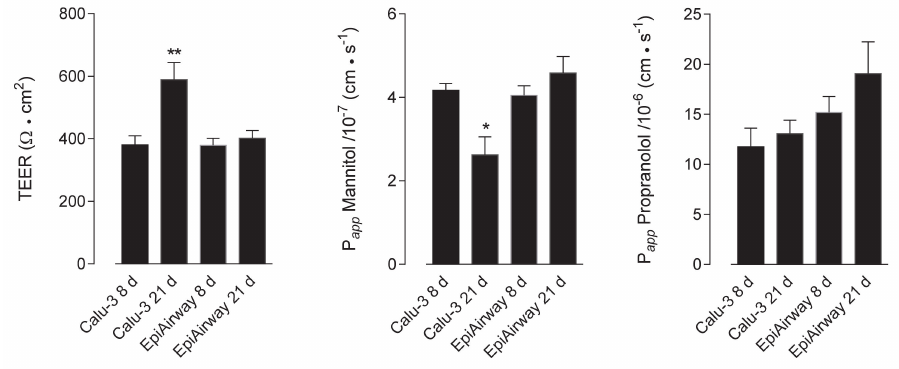
Figure 1. Trans-epitelial electrical resistance (TEER) and cellular permeability ( P app ) in EpiAirway ™ and Calu-3 cells. TEER values and P app of mannitol and propranolol were measured in cells cultured under air–liquid interface (ALI) conditions for 8 d or 21 d, as indicated (see Methods). Bars represent the mean ± standard error of the mean (SEM) of five (TEER), four (mannitol) and three (propranolol) independent determinations. * p < 0.05, ** p < 0.01 vs. other models.